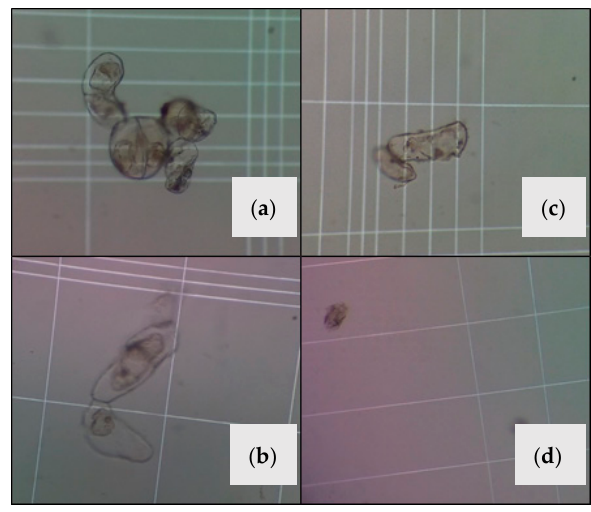
Figure 3. Microscopic (10X) views of cell suspensions of Solanum betaceum : ( a ) large groups, ( b,c ) smaller groups, and ( d ) completely dispersed cells.